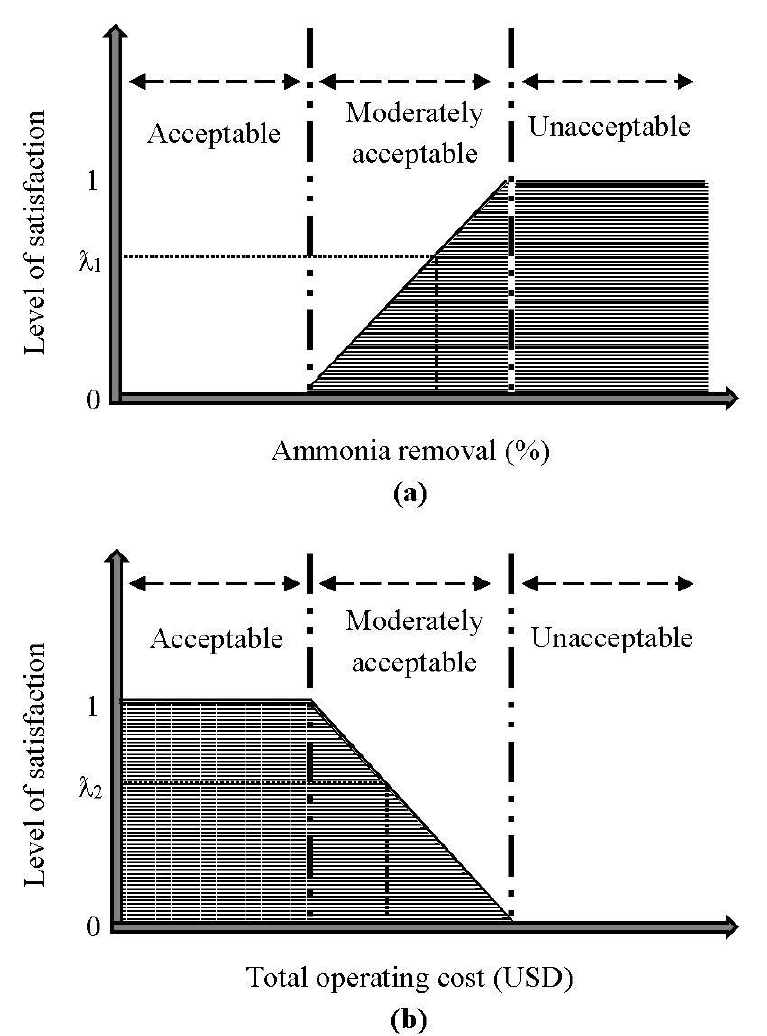
Figure 6. Linear membership function for the ( a ) ammonia removal and ( b ) total operating cost. Table 3. Fuzzy optimal results in the electro-oxidation process based on maximum contaminant levels (MCL) in United States Environmental Protection Agency.